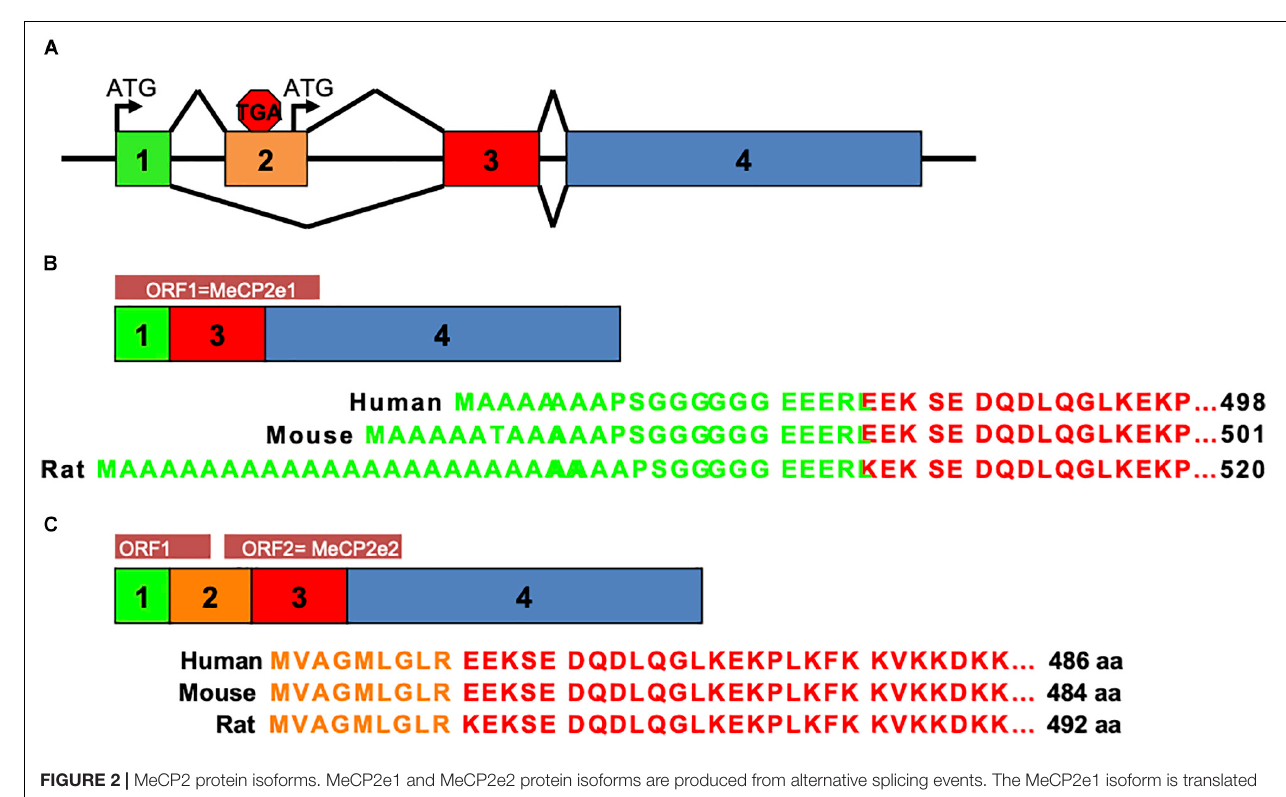
FIGURE 2 | MeCP2 protein isoforms. MeCP2e1 and MeCP2e2 protein isoforms are produced from alternative splicing events. The MeCP2e1 isoform is translated from splicing of exon 1 to exons 3 and 4 with the translational start ATG in exon 1. The MeCP2e2 protein isoform is produced from a transcript from all four exons with a translational start ATG in exon 2. Interestingly, this transcript may encode a small peptide from an ORF in exons 1 and 2. (A) MECP2/Mecp2 exon splicing. (B) MeCP2-e1 isoform. (C) MeCP2-e2